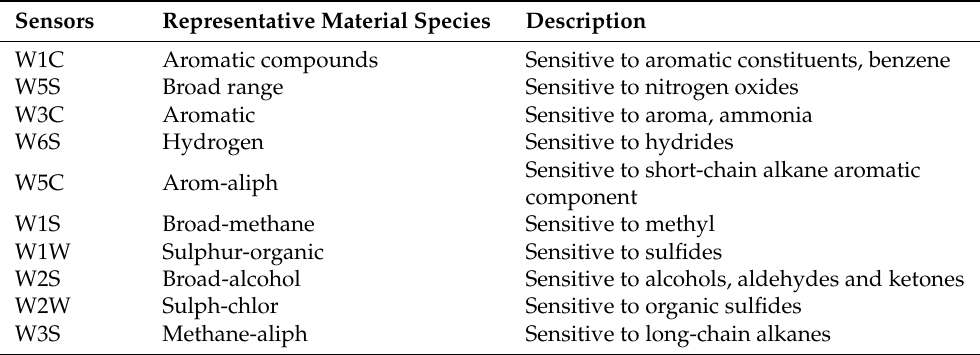
Table 2. Information of 10 sensors for electronic